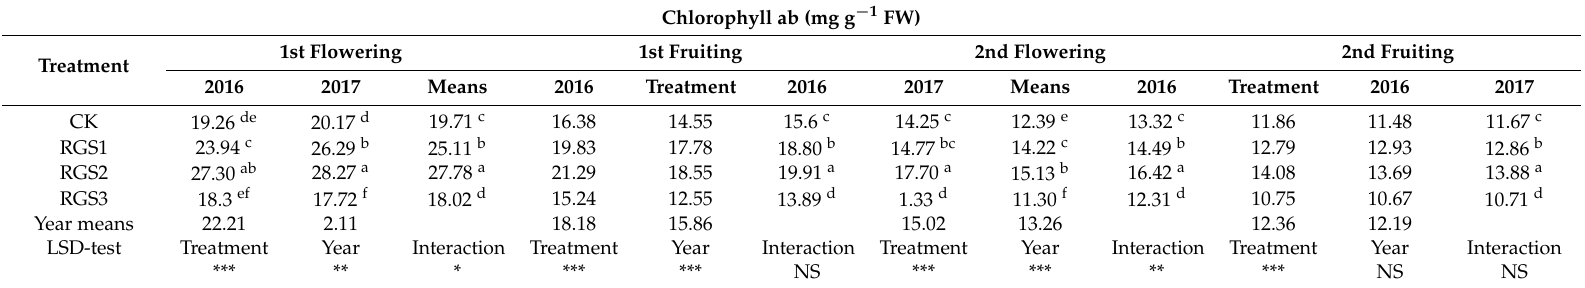
Table 3. Effect of amendment with raw garlic stalk on Chlorophyll ab content in eggplant aboveground biomass.